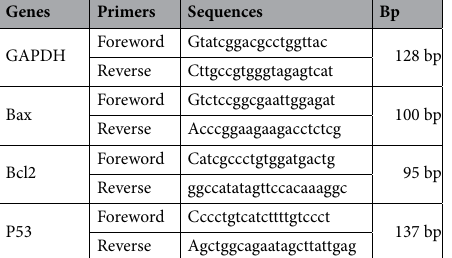
(Table 1) were designed using NCBI Primer blast and synthesized by Invitrogen Company (Carlsbad, CA, USA).